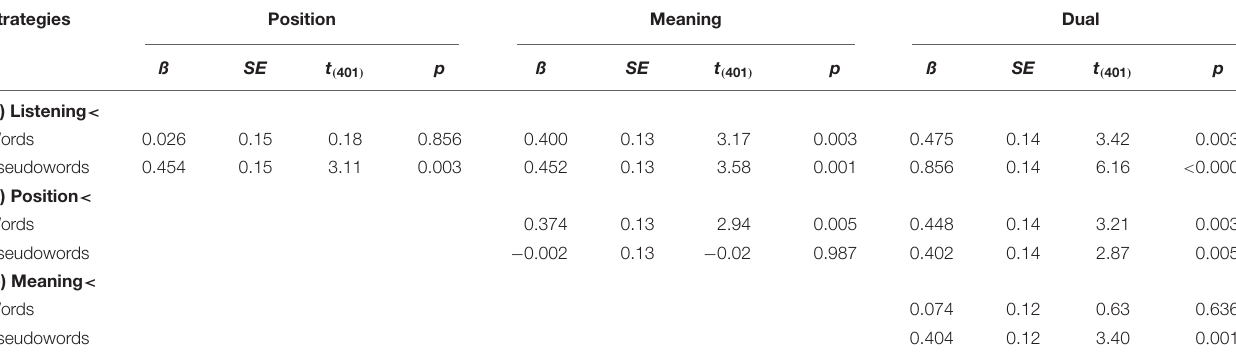
TABLE 6 | Memory performance as a function of self-reported strategy and its interaction with the type of item. Strategies Position